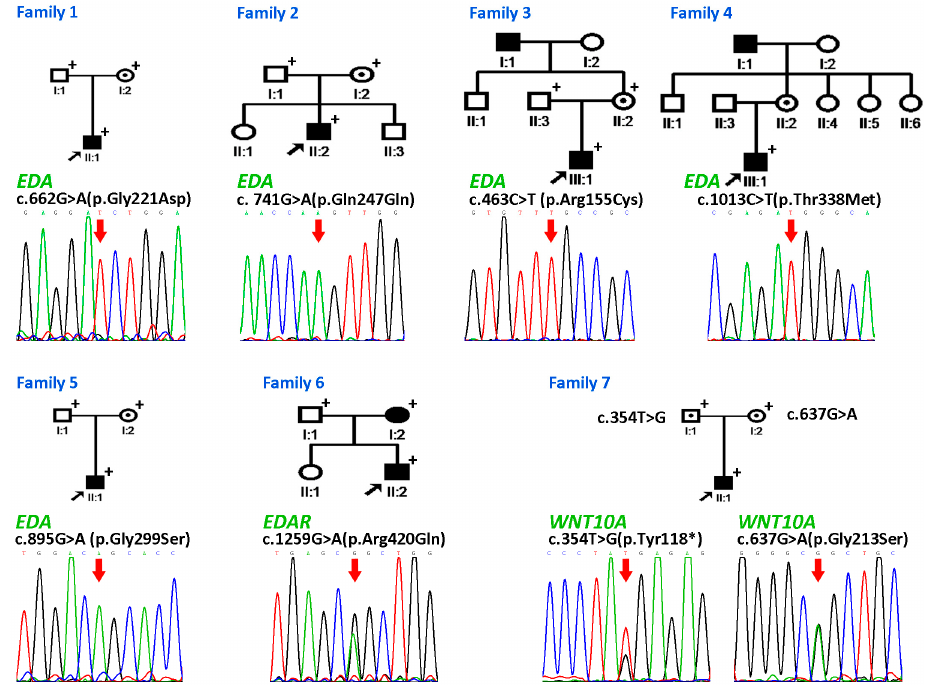
Figure 1. Pedigree and mutations of families 1–7. Families 1–5 harbored Ectodysplasin A (EDA) mutations: c.662G>A (p.Gly221Asp), c.741G>A (p.Gln247Gln), c.463C>T (p.Arg155Cys), c.1013C>T (p.Thr338Met) and c.895G>A (p.Gly299Ser). In family 6, Ectodysplasin A receptor ( EDAR ) mutation c.1259G>A (p.Arg420Gln) was identified. WNT10A mutation c.354T>G (p.Tyr118*) and c.637G>A (p.Gly213Ser) were identified in family 7. Black arrows point to the probands. Red arrows point to the mutations. “+” indicates that the blood sample is available for genetic analysis in this study. In family 1, the sequence chromatogram showed reverse complemented sequence. The remaining sequence chromatograms showed forward